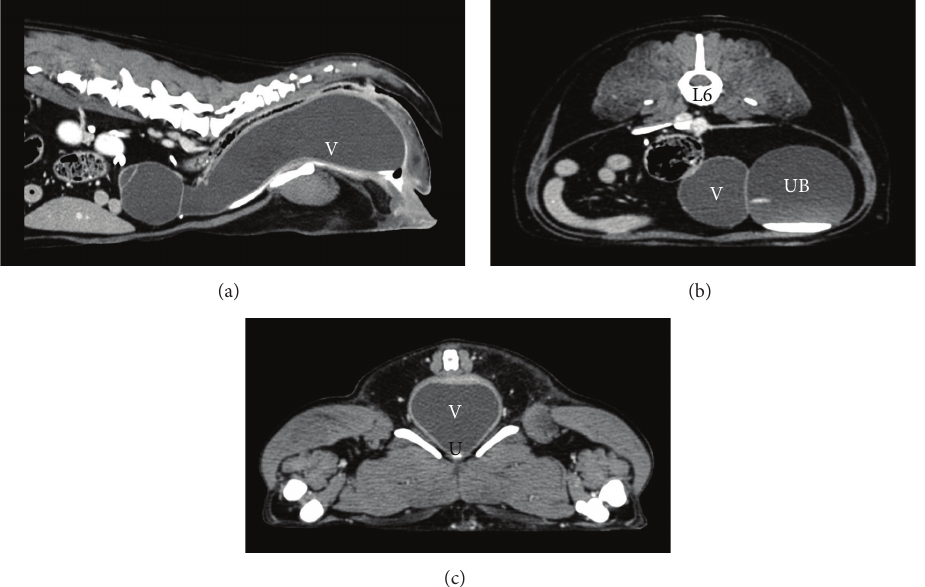
Figure 1: Sagittal (a) and axial (b and c) computed tomography views of the abdomen. (b) and (c) represent the axial view of the abdomen at the level of L6 and the pelvic canal, respectively. The vagina (V), urethra (U), urinary bladder (UB), and L6 are